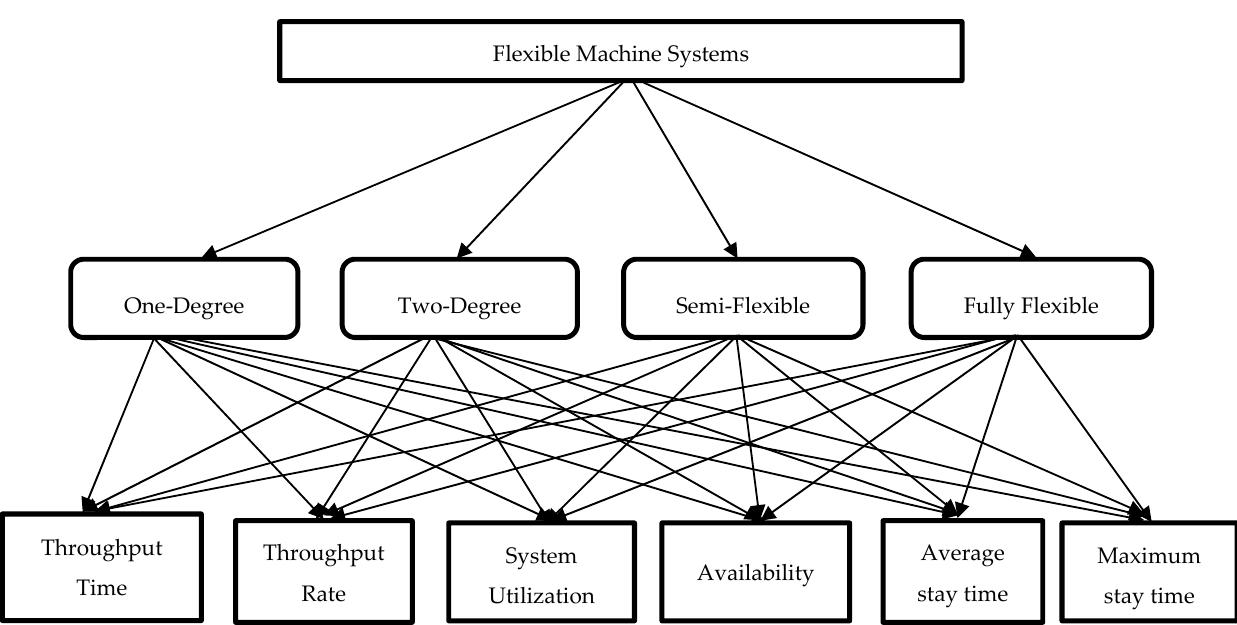
Figure 1. Key parameters used for the flexible machine systems.